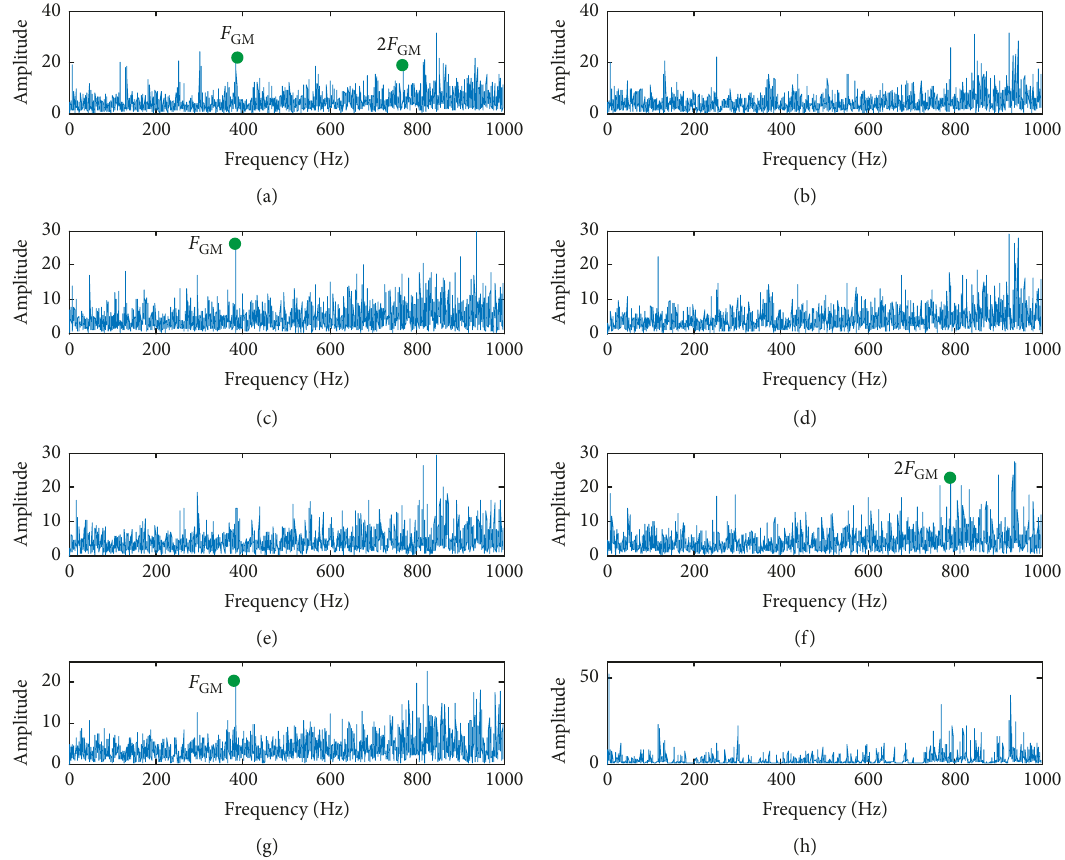
Figure 34: The frequency domain diagram of multiresolution DMD modes of and wear gear signal, where (a)–(h) are corresponding to signals in Figure 30,